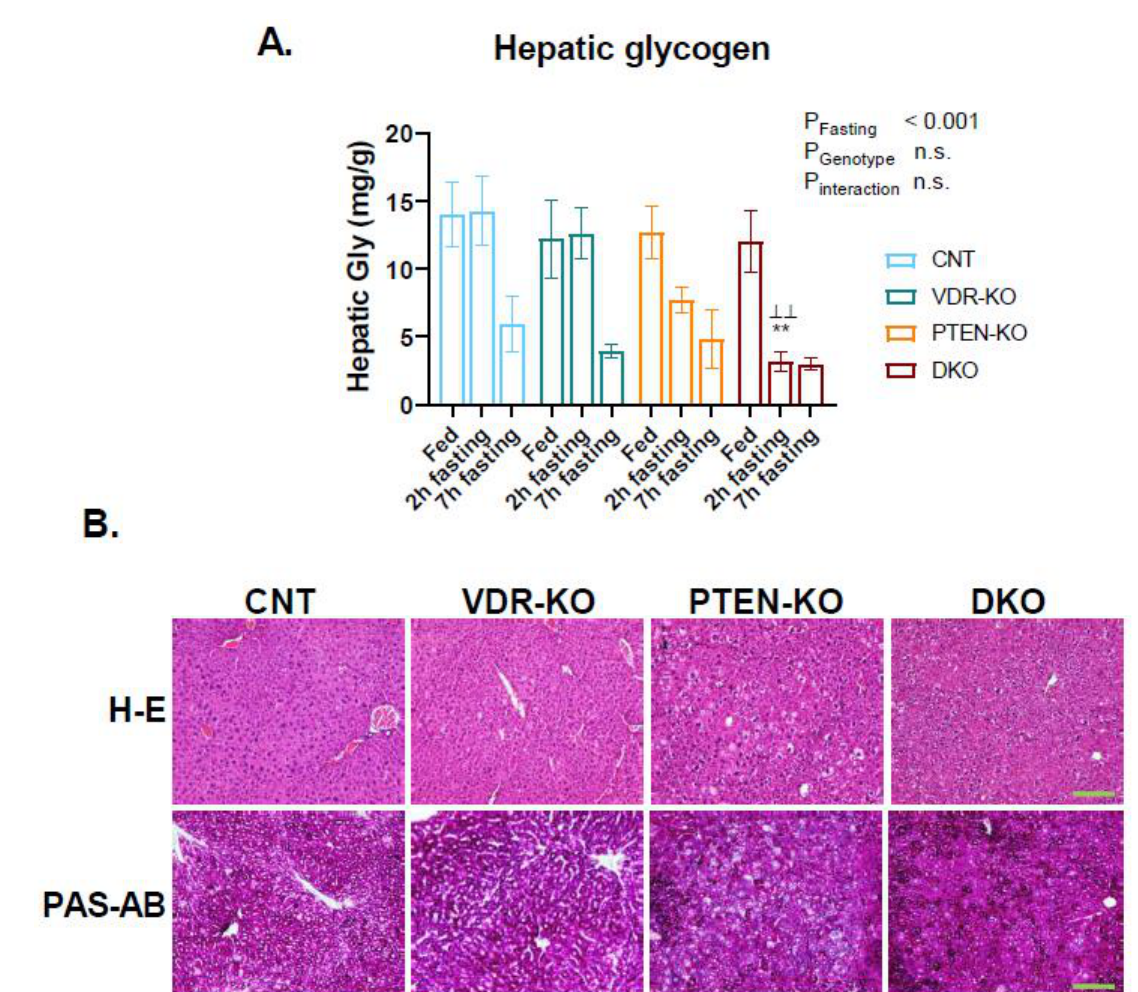
Figure 3. Abnormal glycogen metabolism in PTEN-KO and DKO mice. ( A ) Hepatic glycogen in the fed state and after 2 h and 7 h of fasting. ( B ) Representative microphotographs of liver hematoxylin- eosin and PAS staining for the groups of study. Data are represented as mean ± SEM. ** p < 0.01 vs. CNT; ⊥⊥ p < 0.01 vs. VDR-KO. 100× magnification. Scale bar: 100 µm. CNT: Control. VDR-KO: Vitamin D receptor knockout. PTEN-KO: Phosphatase and tensin homolog knockout. DKO: Double knockout.